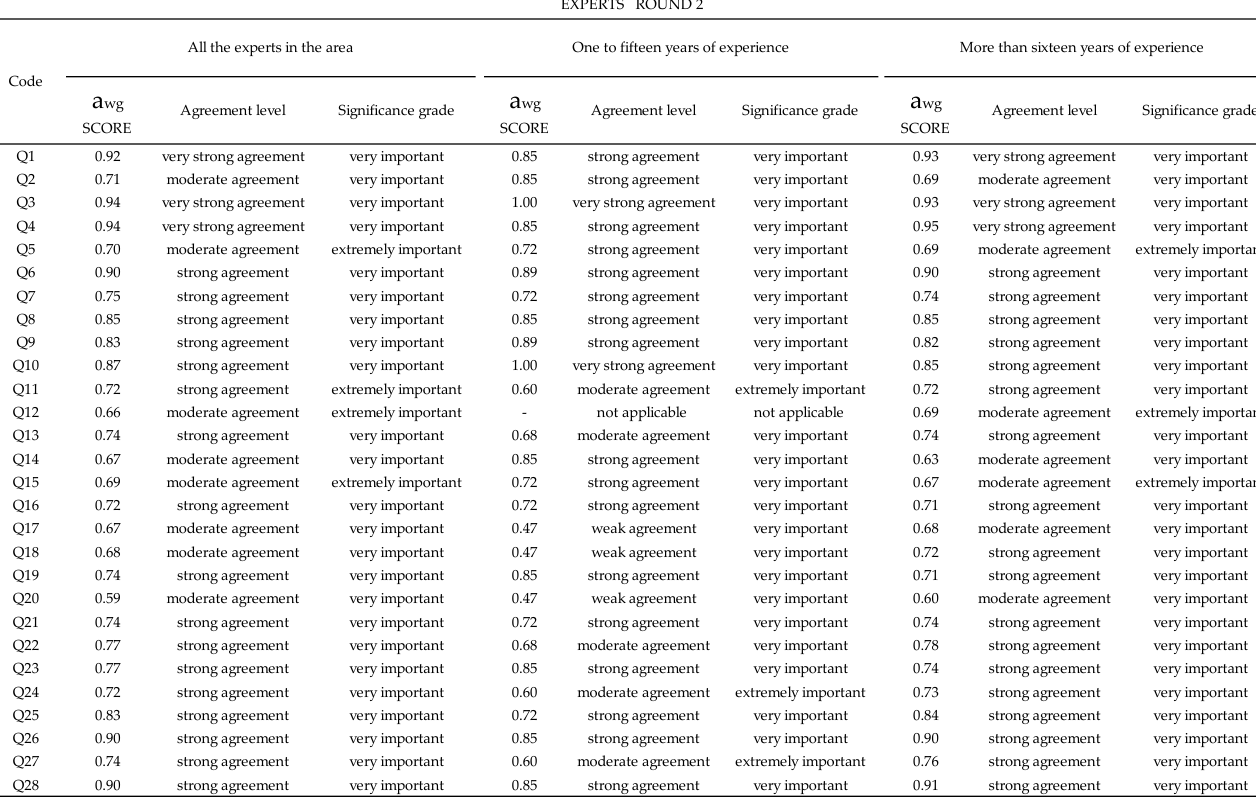
Figure 6. Importance rating and IRA analysis of the factors (benefits) of the second round of experts. Figure 7 presents the process map resulting from integrating the BIM model in steel construction projects after two rounds of the Delphi method.